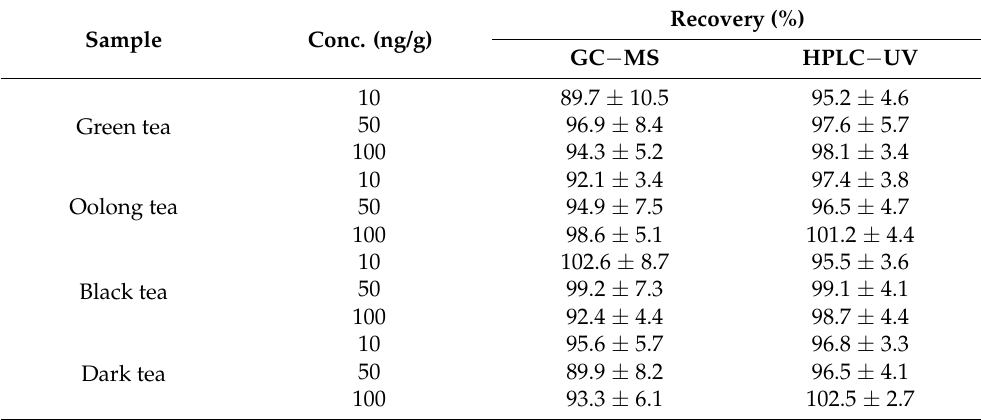
Table 3. Accuracy expressed as % recovery of spiked samples and precision ( n = 5) expressed as standard deviation of GC − MS and HPLC − UV methods.